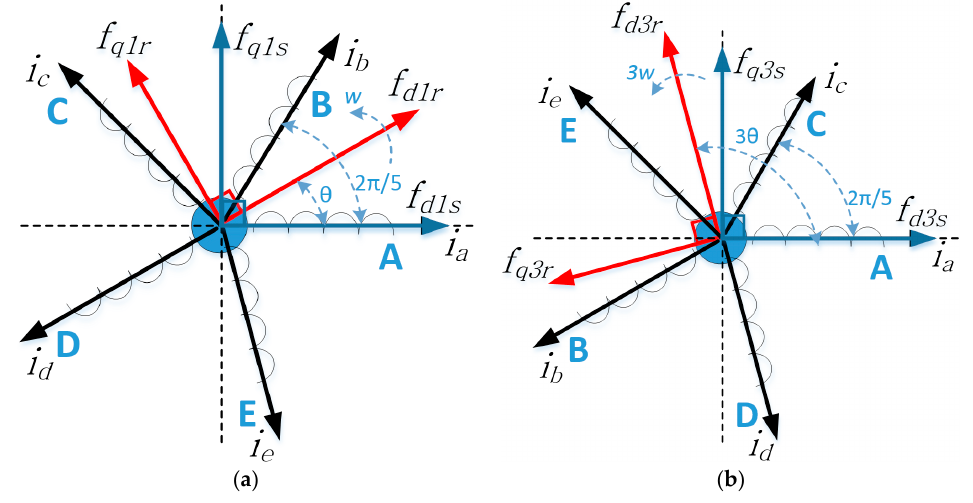
Figure 4. Two orthogonal and two ‐ dimensional spaces of a five ‐ phase IM: ( a ) d 1 ‐ q 1 axis; ( b ) d 3 ‐ q 3 axis.